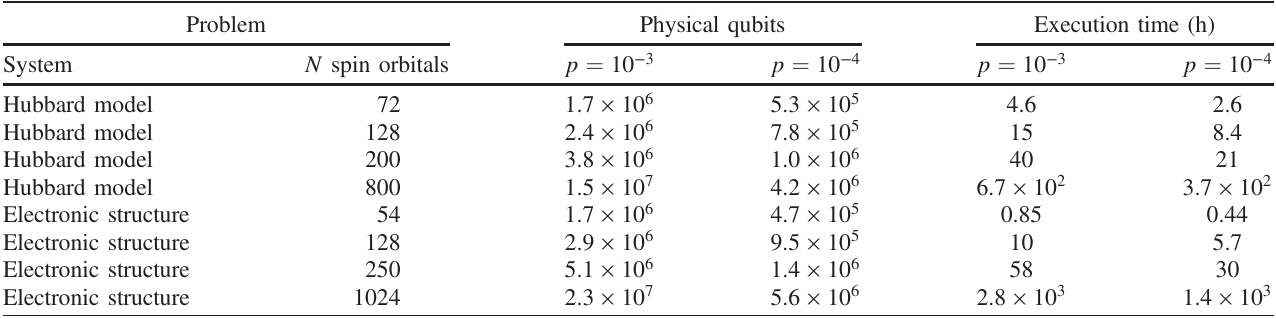
ENCODING ELECTRONIC SPECTRA IN QUANTUM TABLE IX. Automatically generated qubit and time overheads of general chemistry and Hubbard circuits assuming gate error rates of p ¼ 10 − 3 and p ¼ 10 − 4 , a 2D array of nearest-neighbor coupled qubits, and a surface code error-detection cycle time of 1 μ s. The execution time being estimated is the duration of one complete run of the phase estimation process.